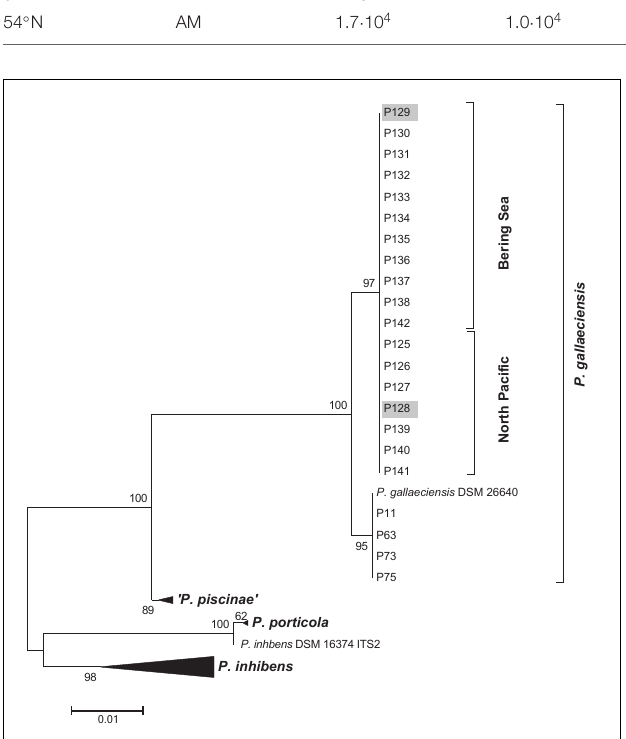
FIGURE 2 | Maximum likelihood phylogenetic tree of Phaeobacter strains based on ITS sequences. For comparison, Phaeobacter strains representing different ITS lineages identified previously (Breider et al., 2017; Freese et al., submitted) were chosen. The tree based on 767 aligned nucleotide positions. Numbers adjacent to branches give percentage of support from 1000 bootstrap replicates. Strains chosen for genome sequencing are marked.